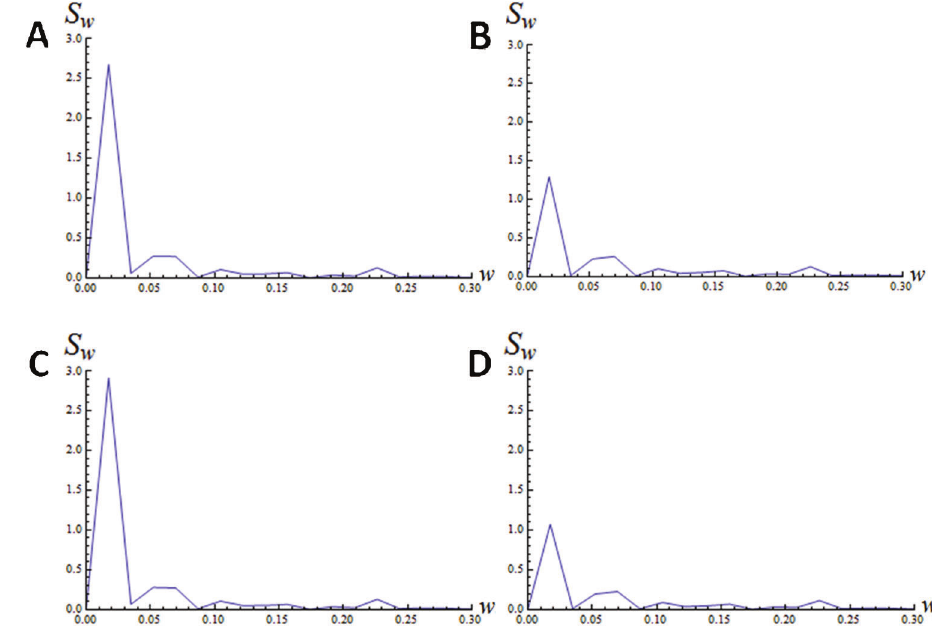
Figure 6. Spectral density function S w of standard diet ( panels A and C ) and high-fat diet rats ( panels B and D